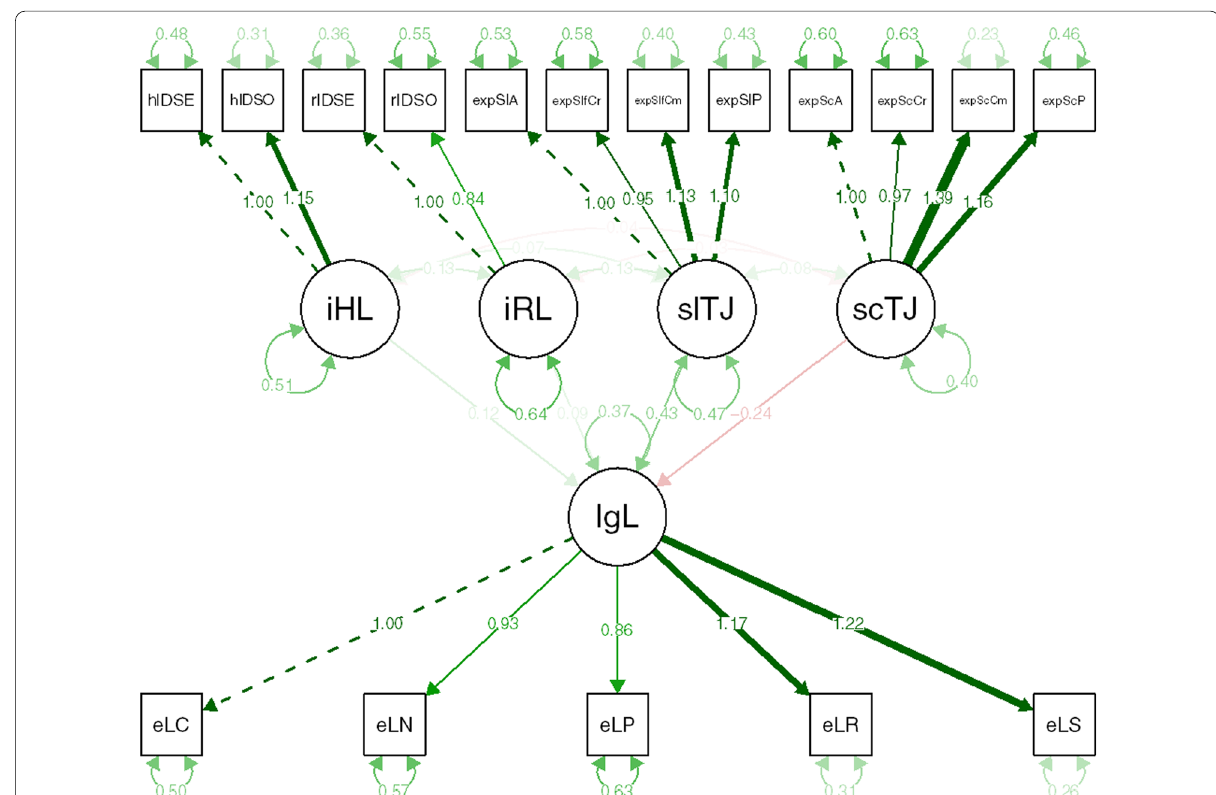
Fig. 2 Structural equation model (Study 3) in which a latent legal judgment variable [lgL] is predicted by a latent implicit hair attitude variable [iHL], a latent implicit race attitude variable [iRL], a latent self trait judgment variable [slTJ], and a latent societal trait judgment variable